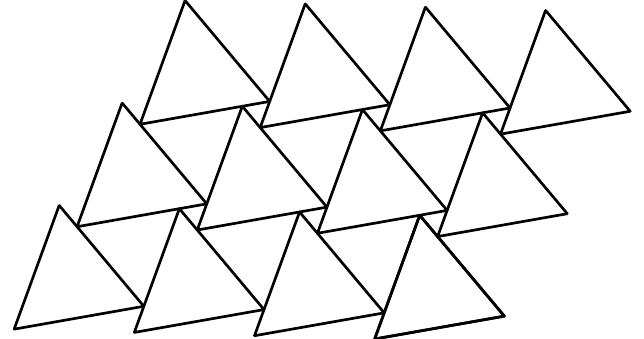
Fig. 63: Tiling with three types of regular triangles (D).